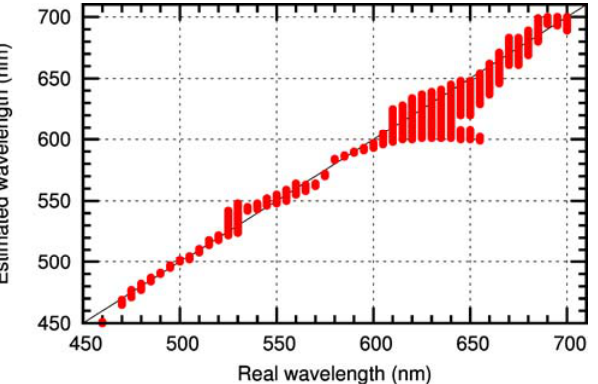
Figure 8. Accuracy of estimated laser wavelengths evaluated by the RGB values of a colour